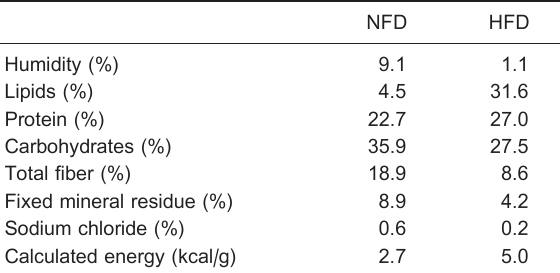
Table 1. Macronutrients and caloric value of normal fat diet (NFD) and high-fat diet (HFD)